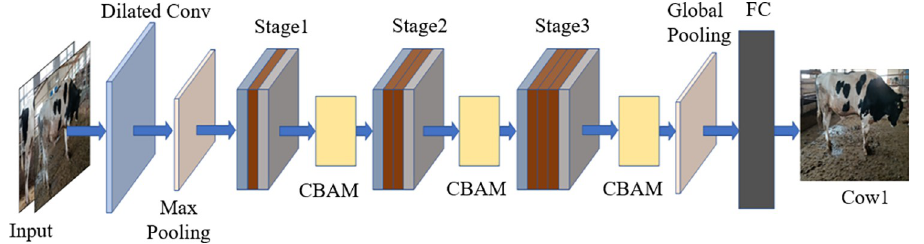
Fig 2. The model structure built in this research.